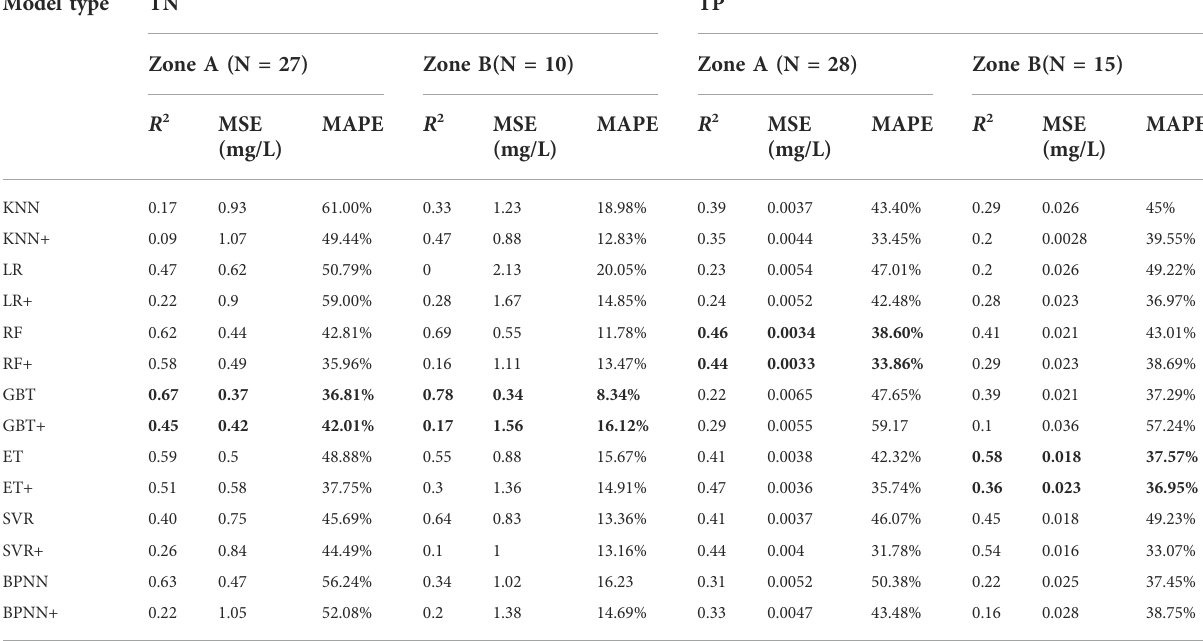
TABLE 2 The accuracy evaluation results for different TN/TP concentration-retrieval models. Model